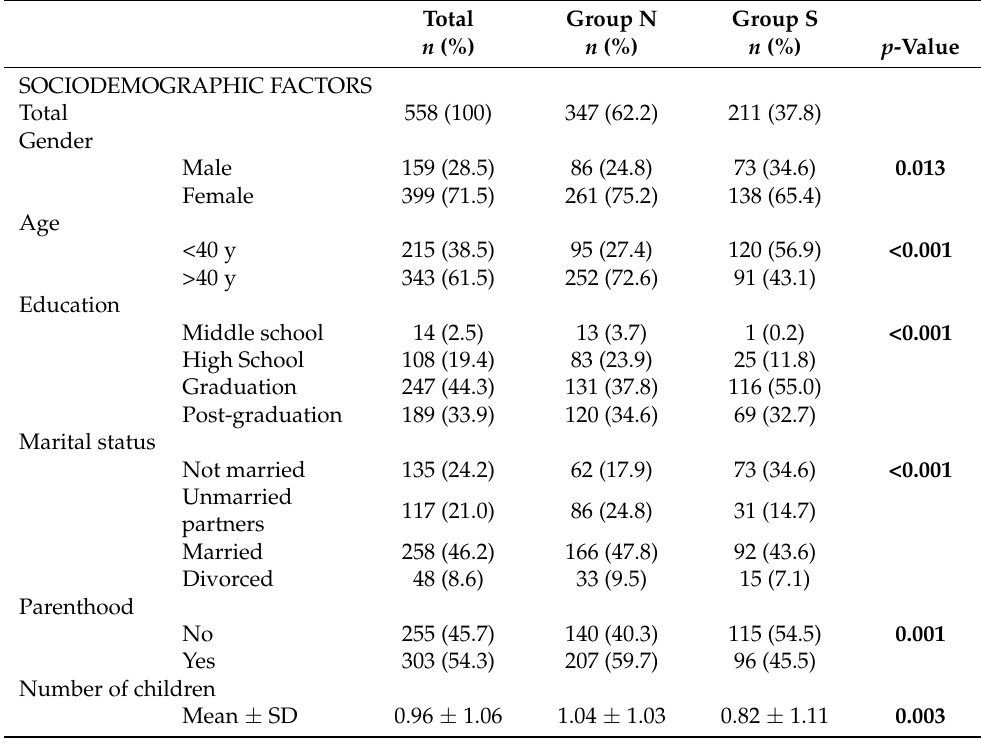
Table 1. Description of study population: sociodemographic characteristics and work-related factors. Total Group N Group S n